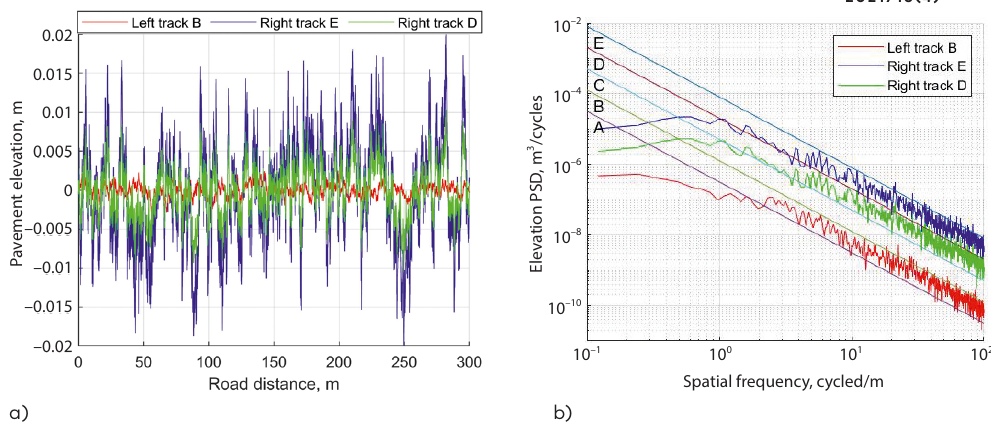
Figure 5. Road pavement input for vehicle model: a) pavement elevation as per road distance; b) elevation spectral density representation according